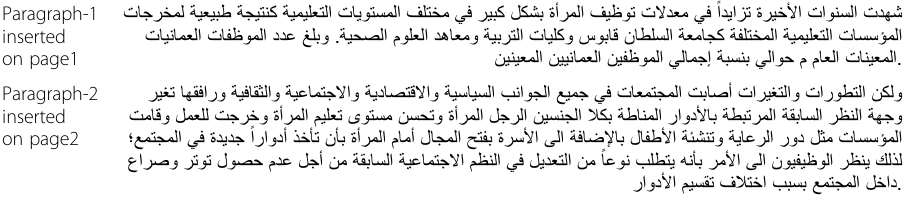
Table 14 Plagiarism-simulated paragraphs injected in the original dataset